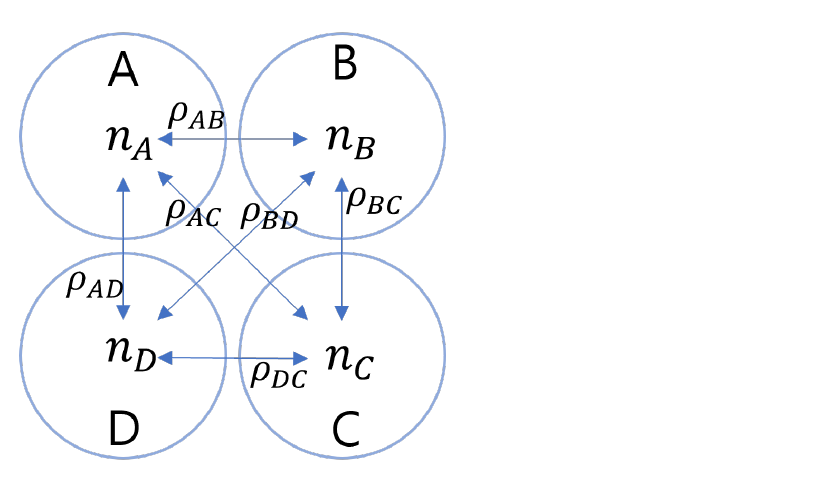
Figure 2. Correlation coefficients between the noise variables received by the four antenna